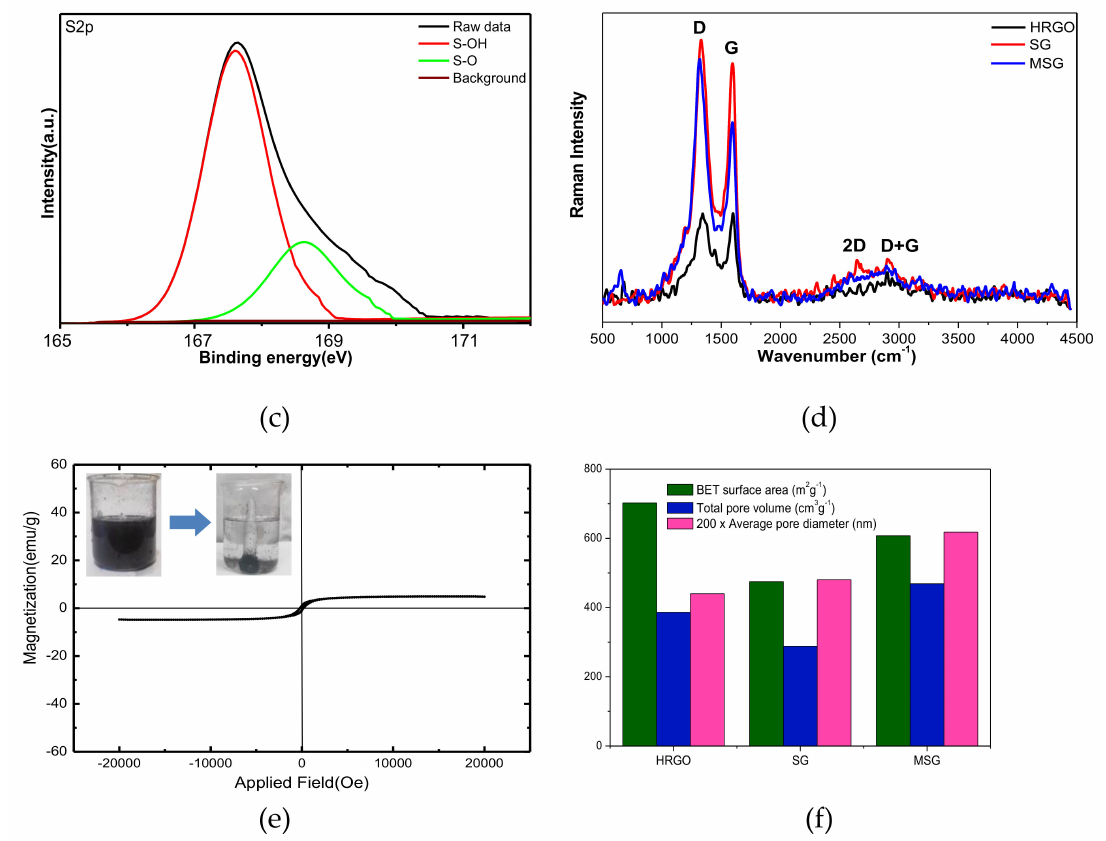
Figure 1. ( a ) X-ray photoelectron spectroscopy (XPS) spectra ( b ) C1s spectra, ( c ) S1s spectra of magnetic sulfonated graphene (MSG) sample, ( d ) Raman patterns, ( e ) Hysteresis loop of the MSG hybrid at room temperature (RT) (The left inset: dispersed and separated particles of MSG by a magnet from the aqueous solution of antibiotic) and ( f ) comparable chart for Brunauer–Emmett–Teller (BET) surface area, average pore diameter and total pore volume of highly-reduced graphene oxide (HRGO), sulfonated graphene (SG), and